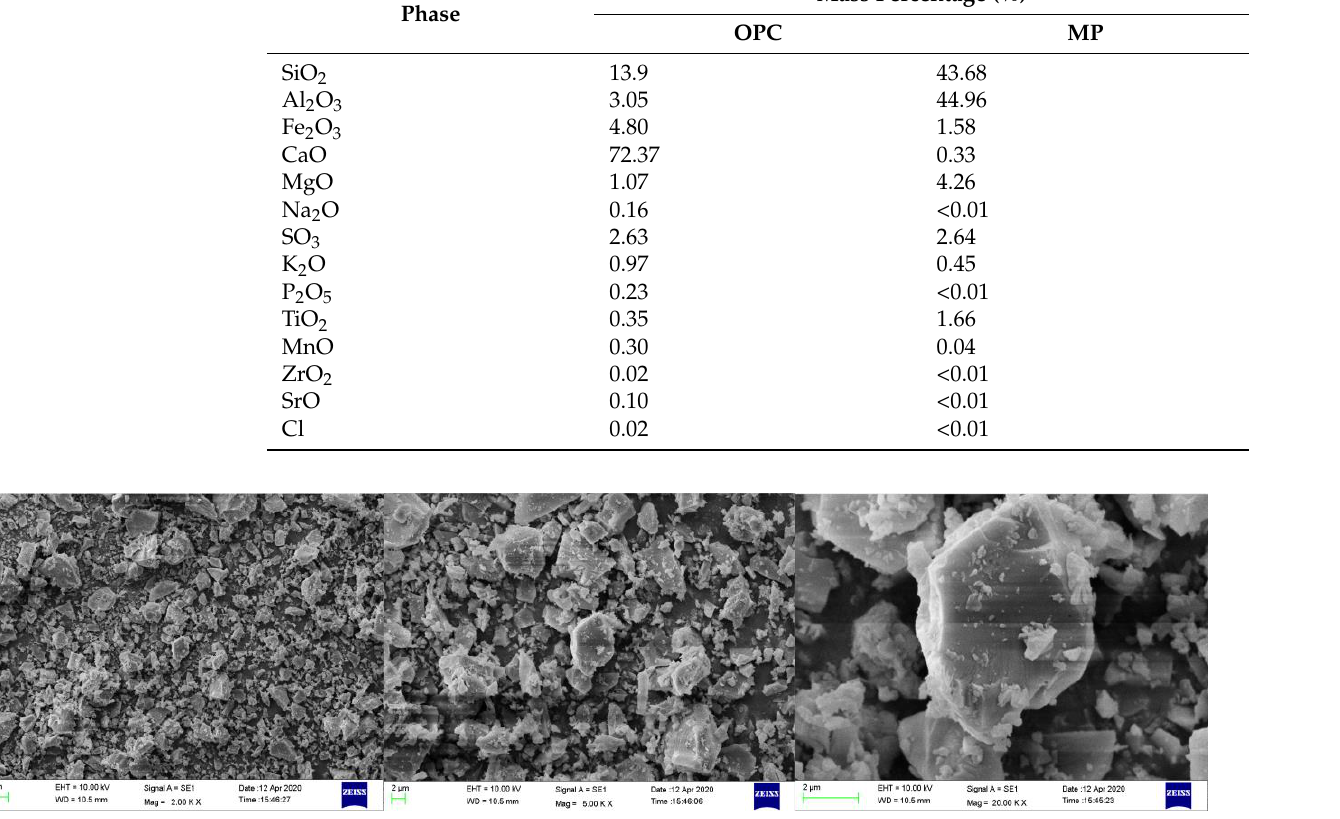
Figure 2. SEM morphology of MP. Table 1. Chemical compositions of MP and OPC.